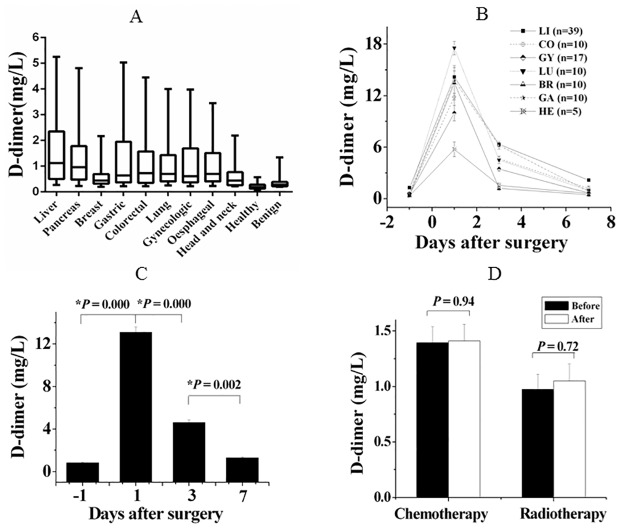
Tumor-specific D-dimer levels and influencing factors.(A) Box diagram of D-dimer levels in cancer patients and healthy controls. Displayed on this diagram are the median, 5th centile, and 95th centile concentrations (solid lines; 5%, 50%, and 95% from bottom to top). (B) Change in D-dimer level in tumour patients with day after surgery. Details of the 101 malignant tumour patients and the procedure for D-dimer measurement are described in the Materials and Methods. The y-axis shows the D-dimer concentration (mg/L). Data were expressed as the mean relative concentration (mg/L) ± the standard error of the mean (SEM). The x-axis shows the number of days after surgery. LI, liver cancer; CO, colorectal cancer; GY, gynaecological tumour; LU, lung cancer; BR, breast cancer; GA, gastric cancer; HE, head and neck cancer. (C) D-dimer levels 1 day, 3 days, and 1 week after surgery compared with that before surgery; P < 0.05 indicates that the difference was statistically significant. (D) The effects of radio/chemotherapy on plasma D-dimer level. D-dimer levels before and after radio/chemotherapy were compared. Plasma samples were collected after one cycle of the therapy. Details of the 130 malignant tumour patients and the procedure for D-dimer measurement are described in the Materials and Methods. The y-axis represents D-dimer level (mg/L). Data were expressed as the mean relative concentration (mg/L) ± SEM. The x-axis represents before and after radio/chemotherapy. P < 0.05 indicates that the difference was statistically significant.